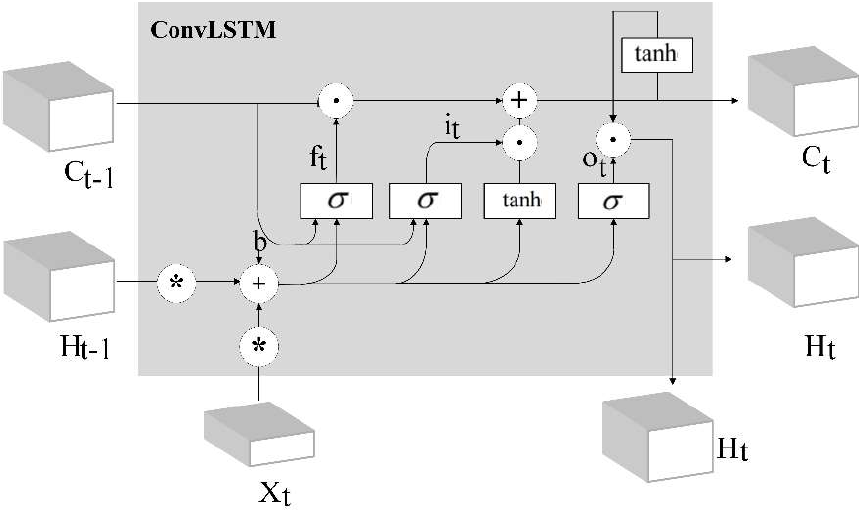
Figure 4. The structure of convolution LSTM.